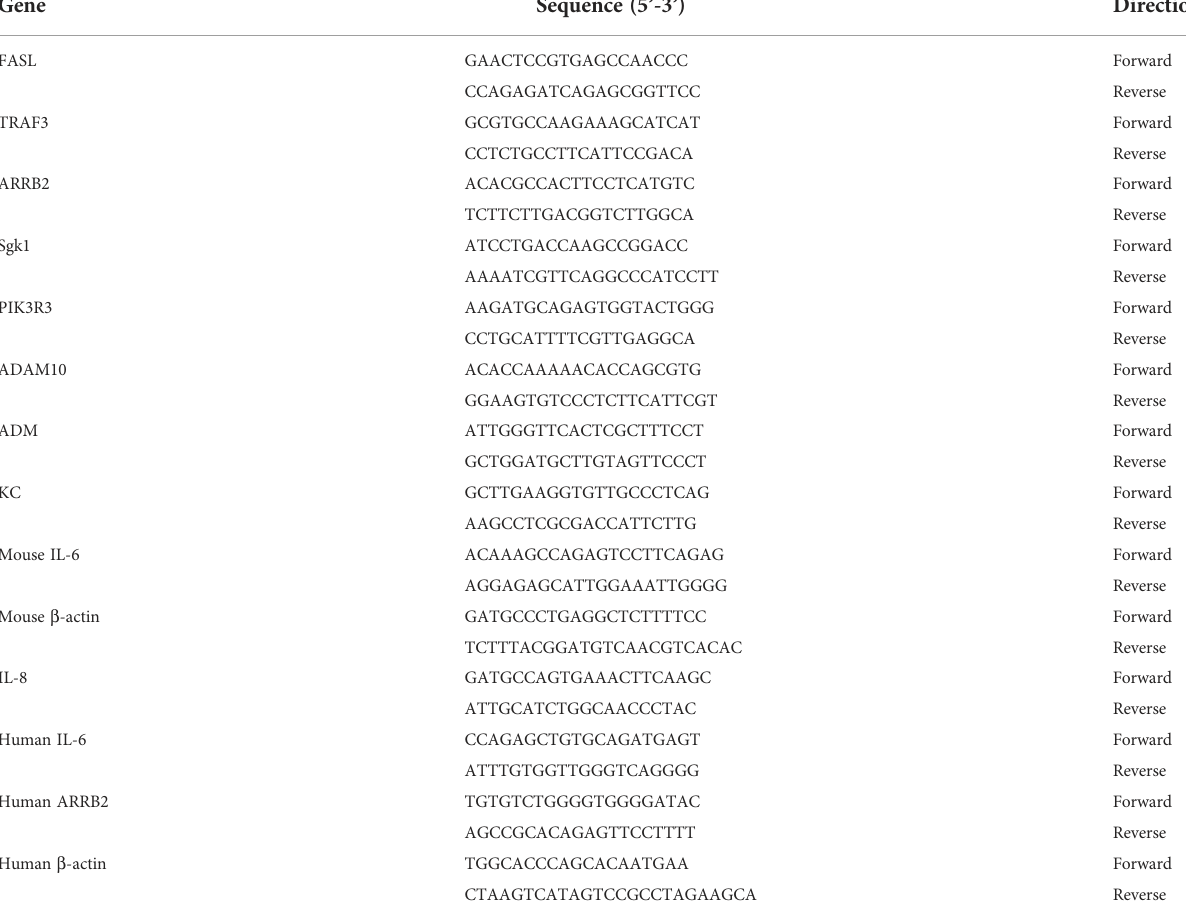
TABLE 1 The sequence of primers for real-time PCR.